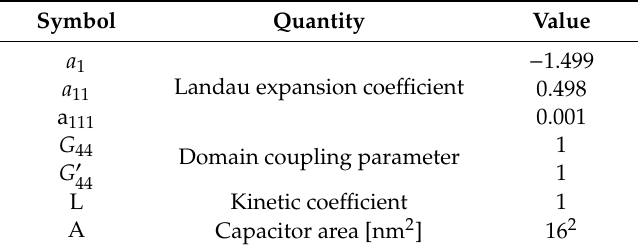
Table 1. Normalized parameters for a resistance-ferroelectric capacitor (R-FEC) circuit [25]. Symbol Quantity Value − 1.499 a 1 Landau expansion coe ffi cient